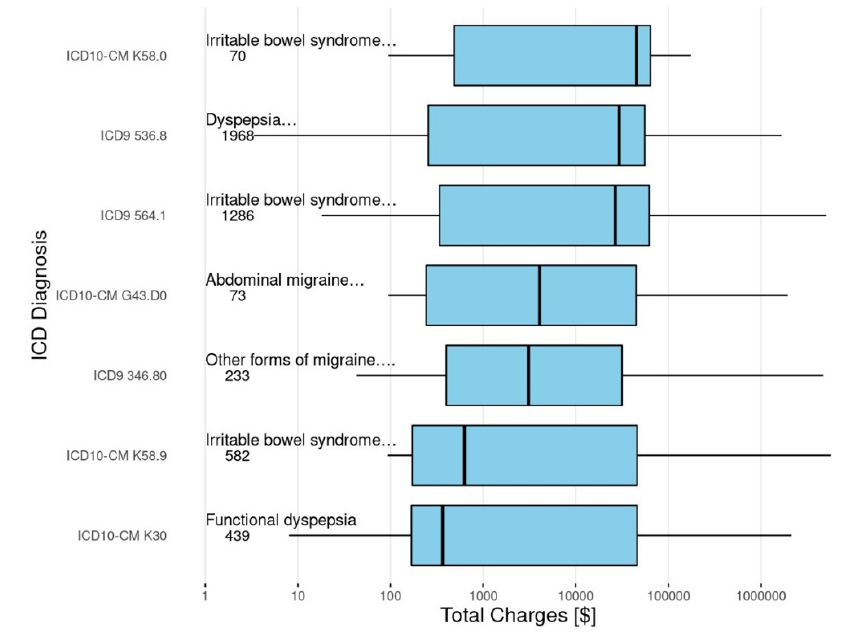
Figure 5. Patient charges across AP-FGID diagnoses.